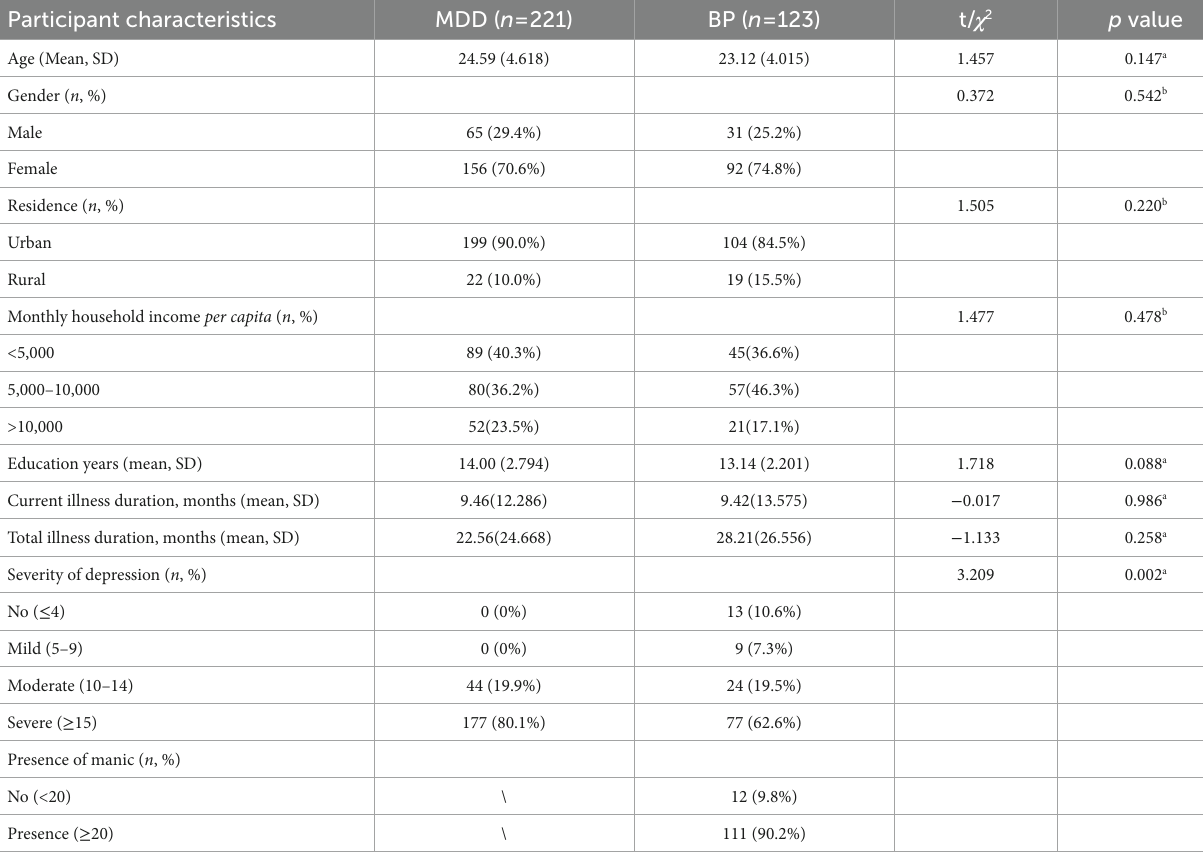
TABLE 1 Demographic and clinical characteristics of the MDD and BD groups. Participant